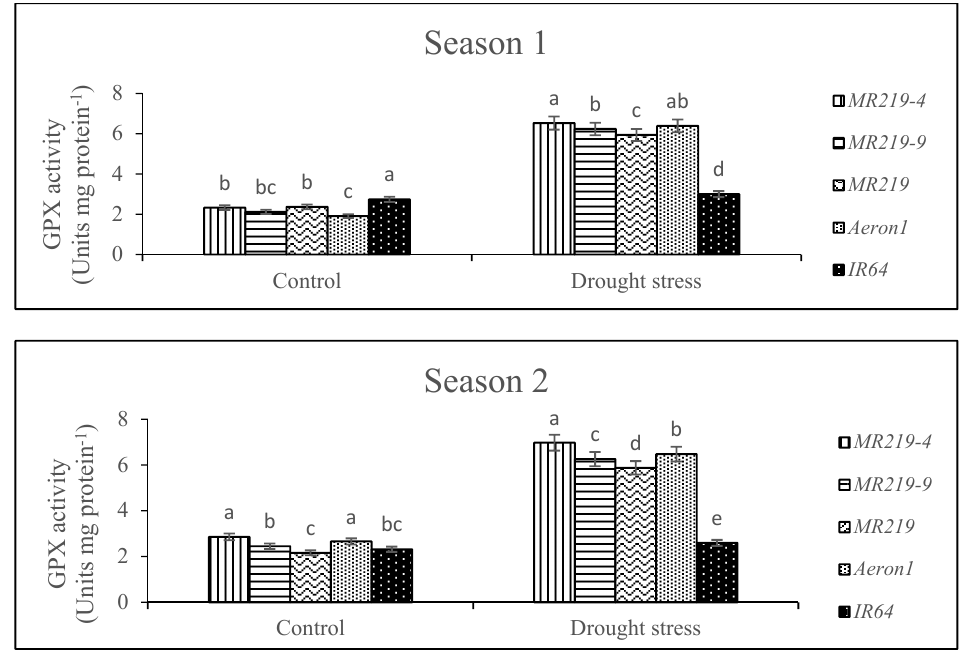
Figure 5. Effect of drought stress treatment on GPX activities in rice genotypes. Vertical bars represent ± standard error. Values within drought stress treatment with the different letter are significantly different based on comparison using DNMRT at p ≤ 0.01 ( n = 20).